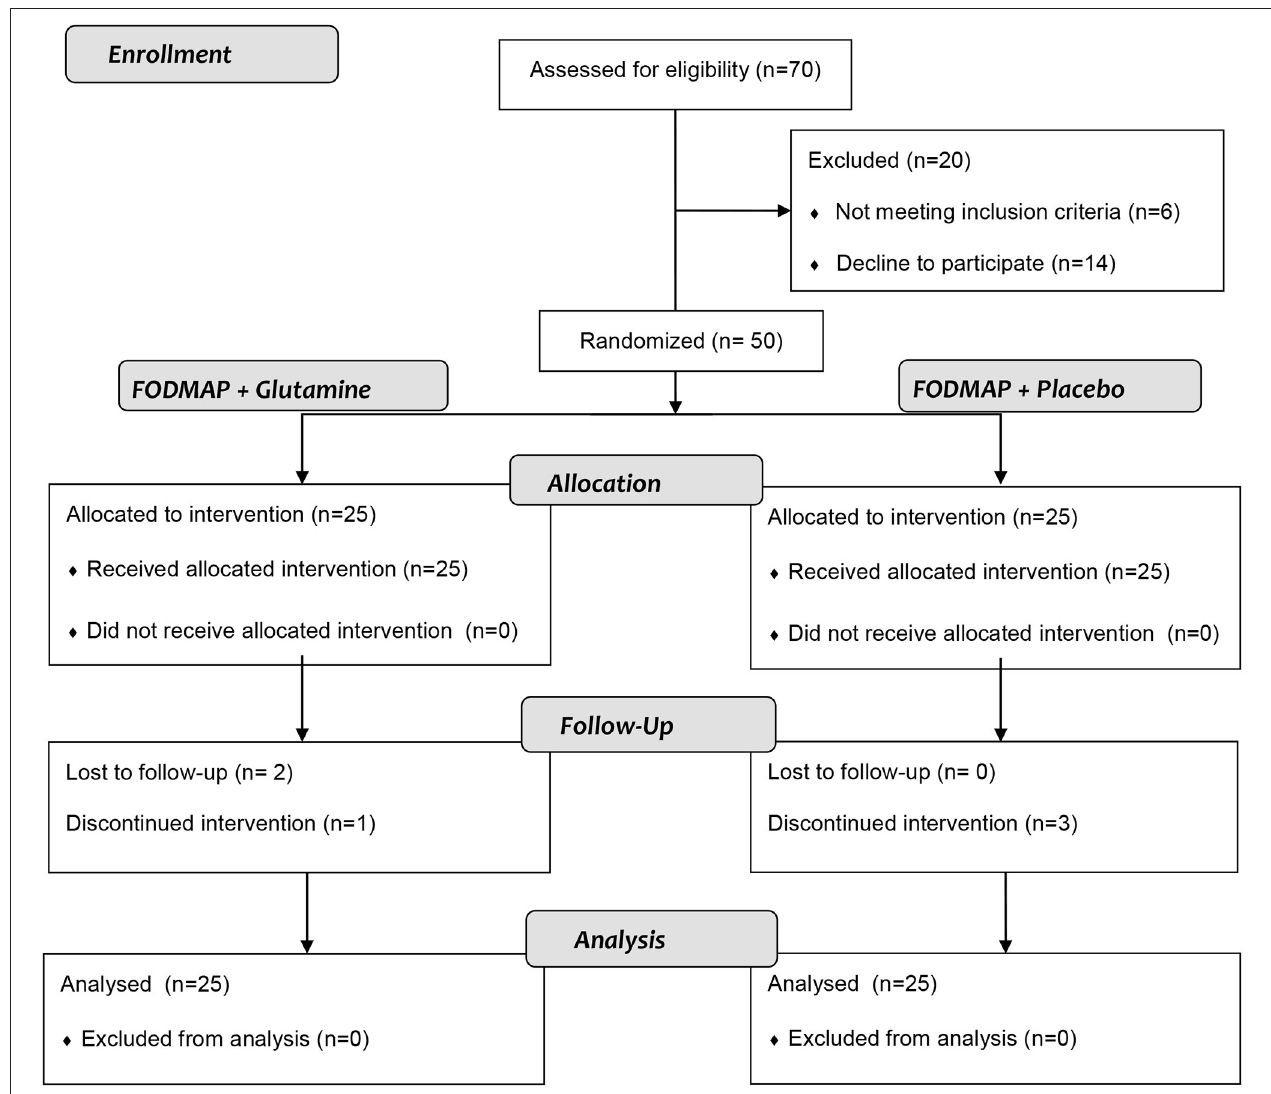
FIGURE 1 | Consort flow chart of the